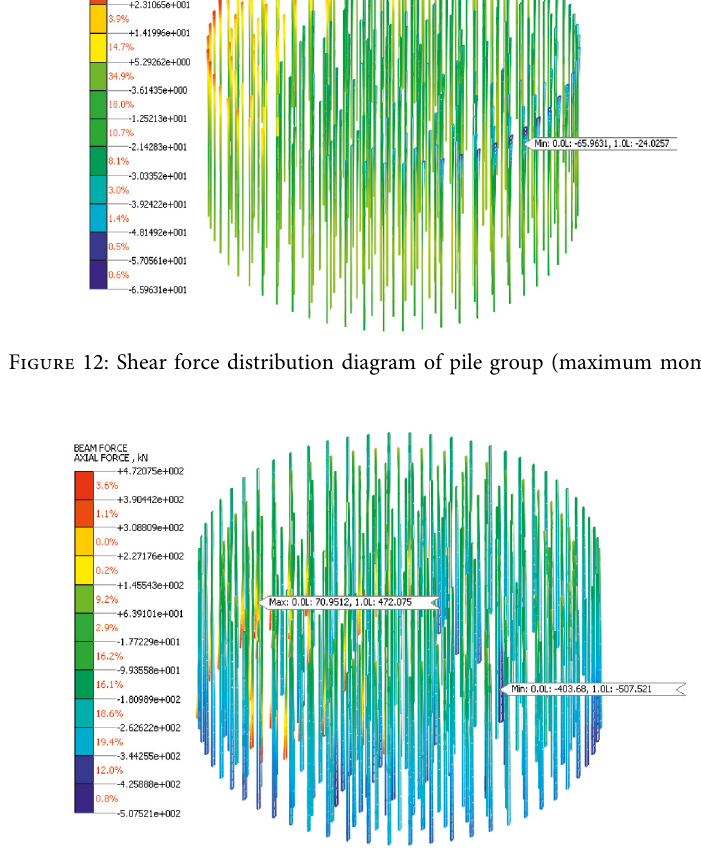
Figure 13: Axial force distribution diagram of pile group (maximum moment) (absolute MAX).